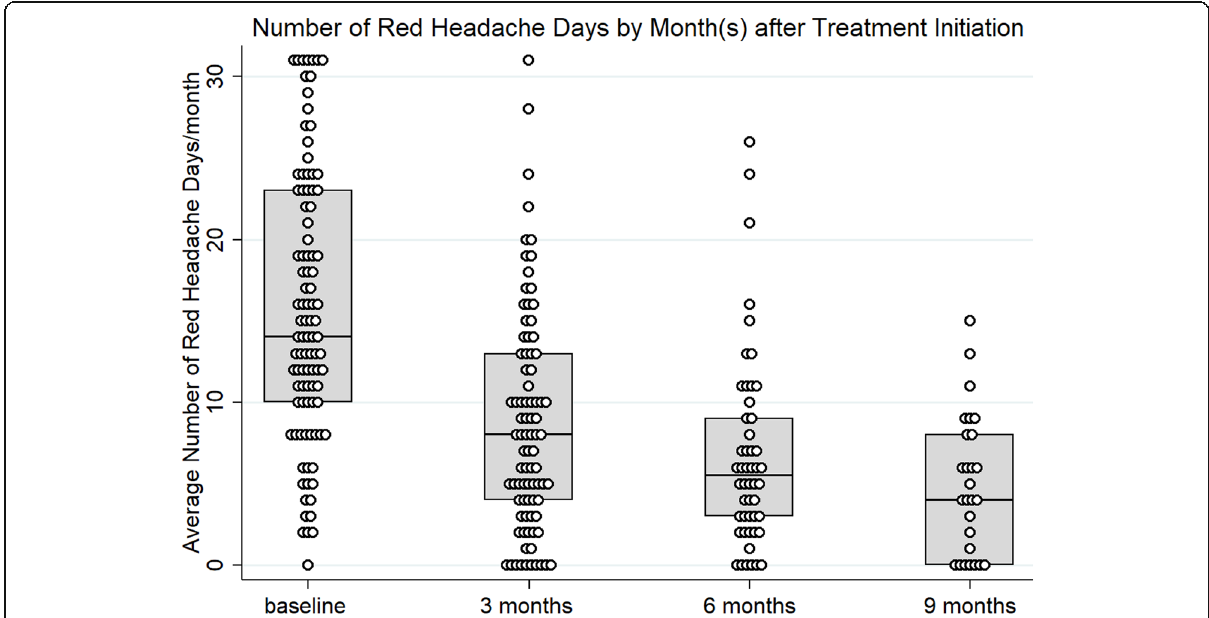
Fig. 2 Box plots with dot plots, showing the number of red headache days/month at baseline (month 2) and 3, 6 and 9 months after treatment initiation (respectively months 5, 8 and